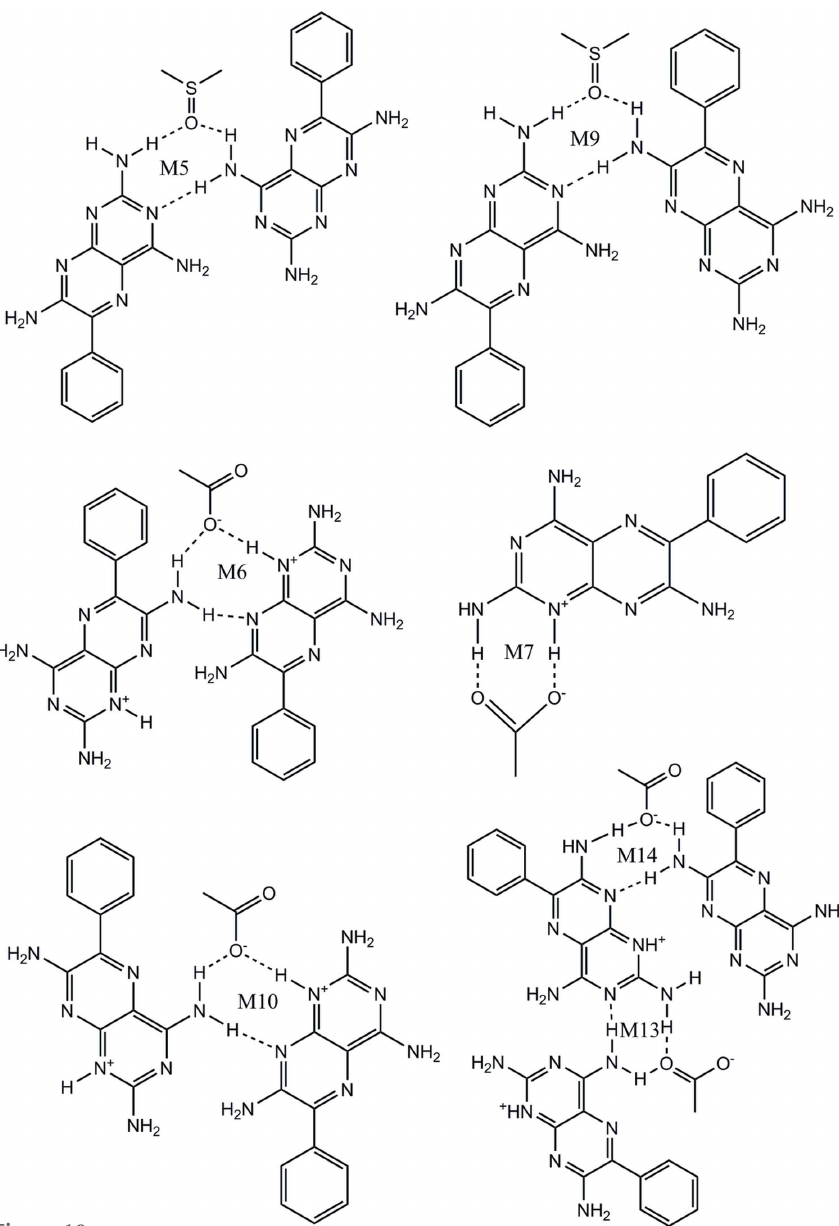
Figure 19 Hydrogen-bonded motifs of 1 –solvent and 1 –coformer molecules observed in this study.